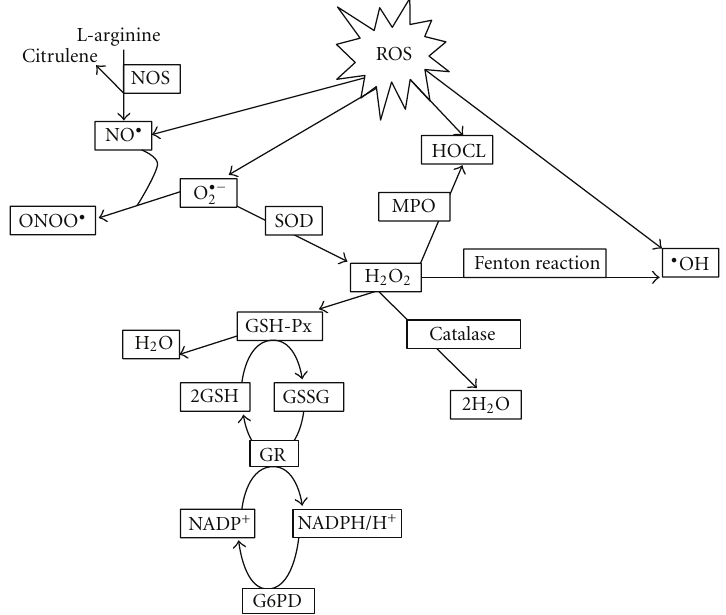
Figure 1: Shown are di ff erent types of reactive oxygen species (ROS). Abbreviations: GSH-Px: Glutathione peroxidase; HOCl: Hypochlorous acid; H 2 O 2 : Hydrogen peroxide; MPO: Myeloperoxidase; NO • : Nitric oxide; NOS: NO synthase; O 2 •− : Superoxide anion; • OH: Hydroxyl radical; ONOO • : Peroxynitrite anion;SOD: Superoxide dismutase;NADPH: Nicotinamide adenine diphosphate; GSH: Reduced glutathione; GR: Glutathione reductase; G6PD: Glucose-6-phosphate